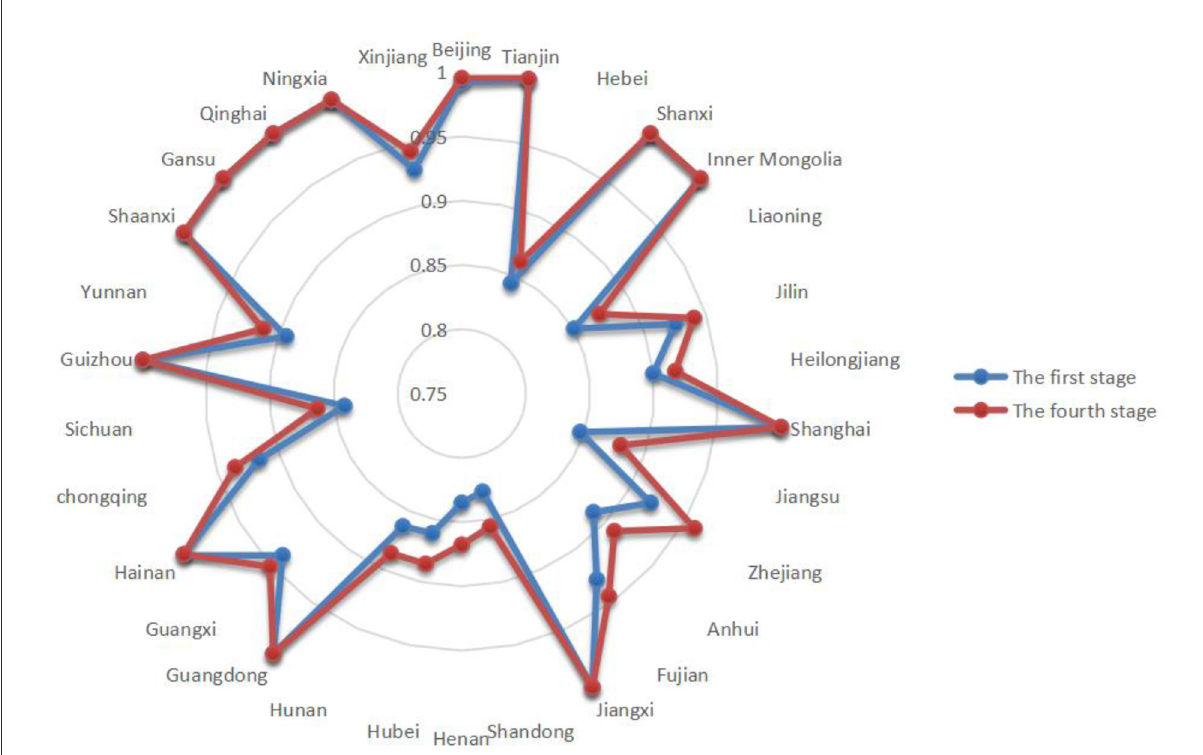
FIGURE5 Comparison of the efficiency values of the first and fourth stages in